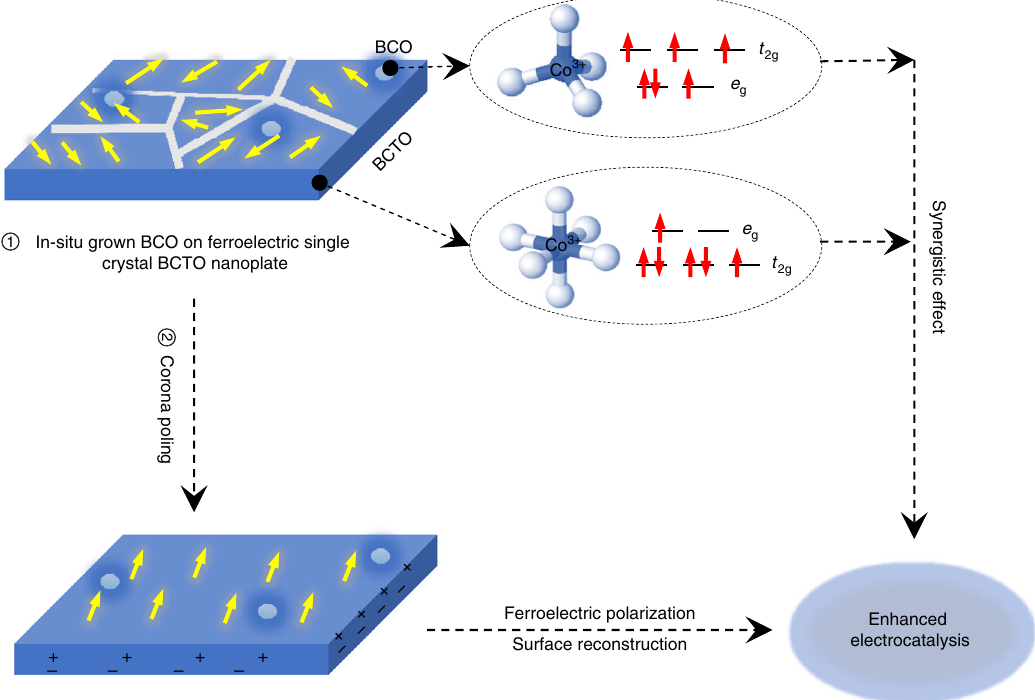
Fig. 7 Illustration to demonstrate the advantages of the in situ as-prepared BCO/BCTO nanostructures for electrocatalysis. The Co ions of the in situ grown BCO are tetrahedrally coordinated with ( e g ) 3 ( t 2g ) 3 , while Co ions of the ferroelectric BCTO are octahedrally coordinated with ( t 2g ) 5 ( e g ) 1 , and these two different con fi gurations have a synergistic effect on the overall OER ef fi ciency. By corona poling, the ferroelectric polarization together with an induced surface modi fi cation can greatly enhance the OER